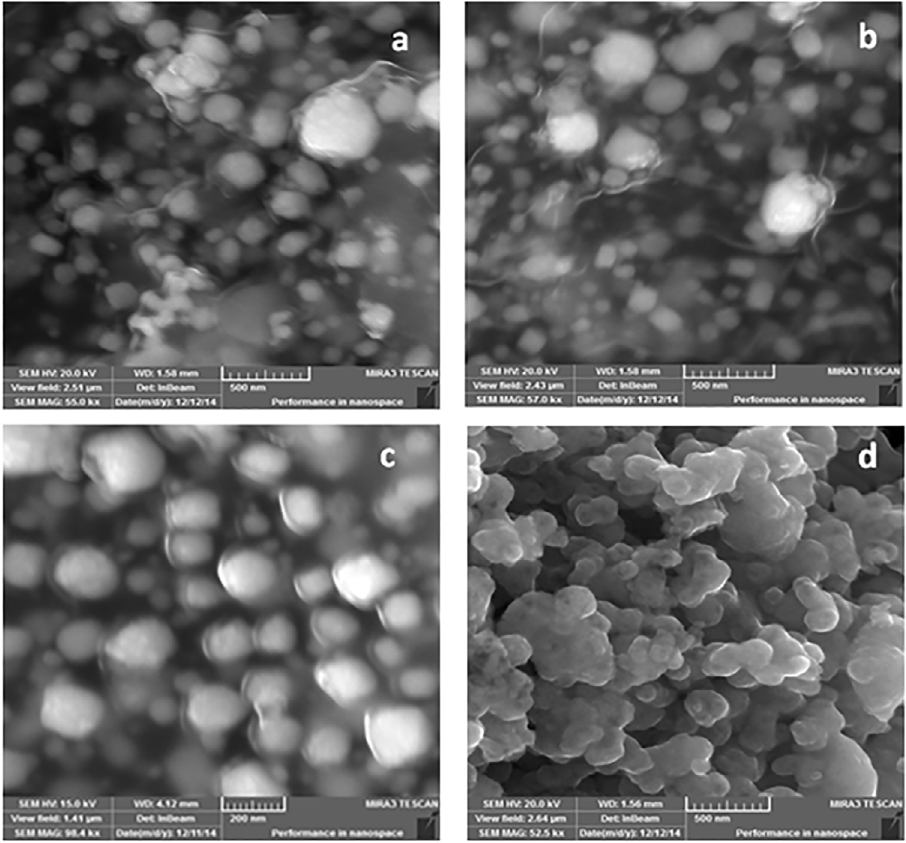
Figure 5. Scanning electron microscopy images for the sample CS-400.